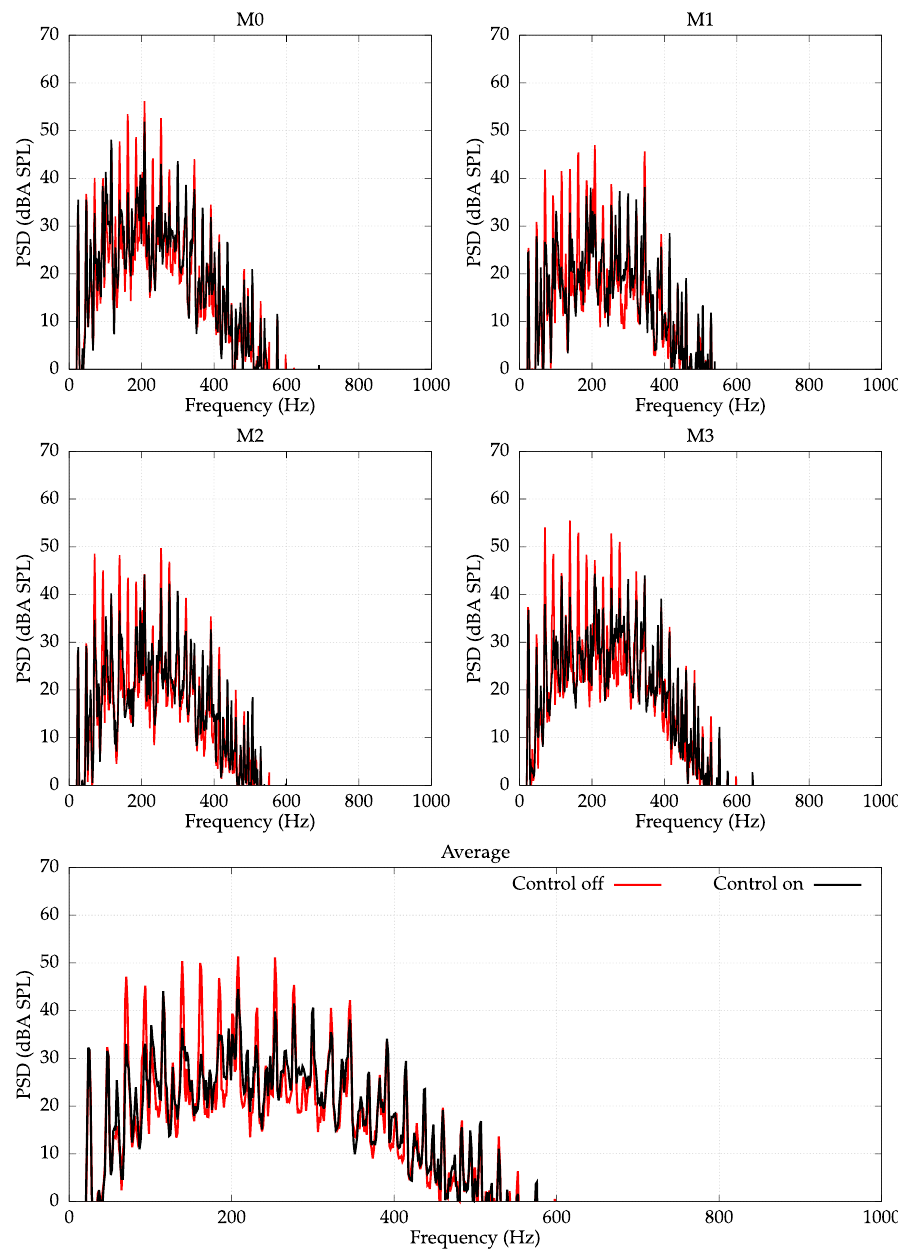
Figure 10. PSD with an A-weighting measured at monitoring microphones M0–M3. Unbalanced load of 500 g. Spin velocity 1340 RPM. The signals are filtered with a lowpass filter of cutoff frequency f c = 300 Hz. Average reduction: 6